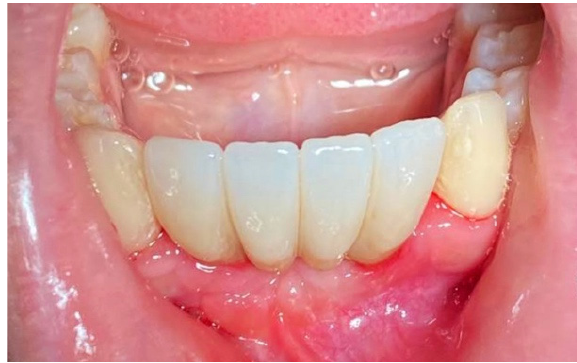
Figure 18. prosthetic finalization of the case and mucose quality.